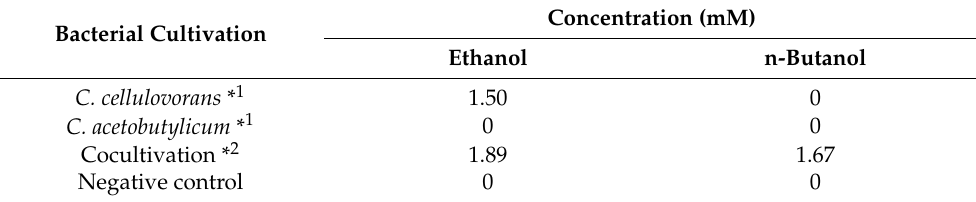
Table 1. Concentrations of ethanol and n-butanol from the different cultivations with shredded paper. Bacterial Cultivation